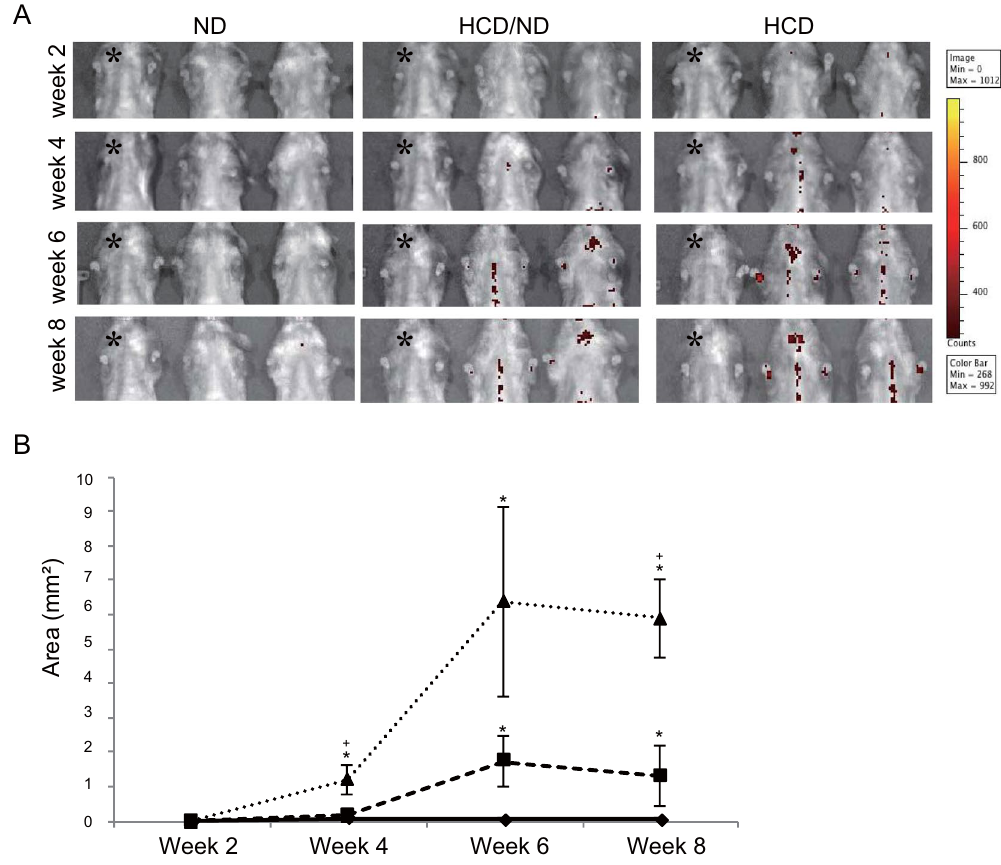
Figure 6. iRFP imaging system enables to the observation of the time course of plaque progression in vivo . ( A ) Thoracic IVIS images of mice in all three groups were acquired every 2 weeks. The ND-fed iRFP → LDLR − / − mice were used as a negative control in each imaging session and are denoted by * here. ( B ) The mean signal area of each group is plotted from week 2 to week 8. (triangle, “HCD group”; square, “HCD/ND group”; diamond; “ND group”). The data are from one representative experiment of at least two independent experiments. Quantified data are presented as the mean ± s.e.m. * P < 0.05 versus the ND group, + P < 0.05 versus the HCD/ND group (Student’s